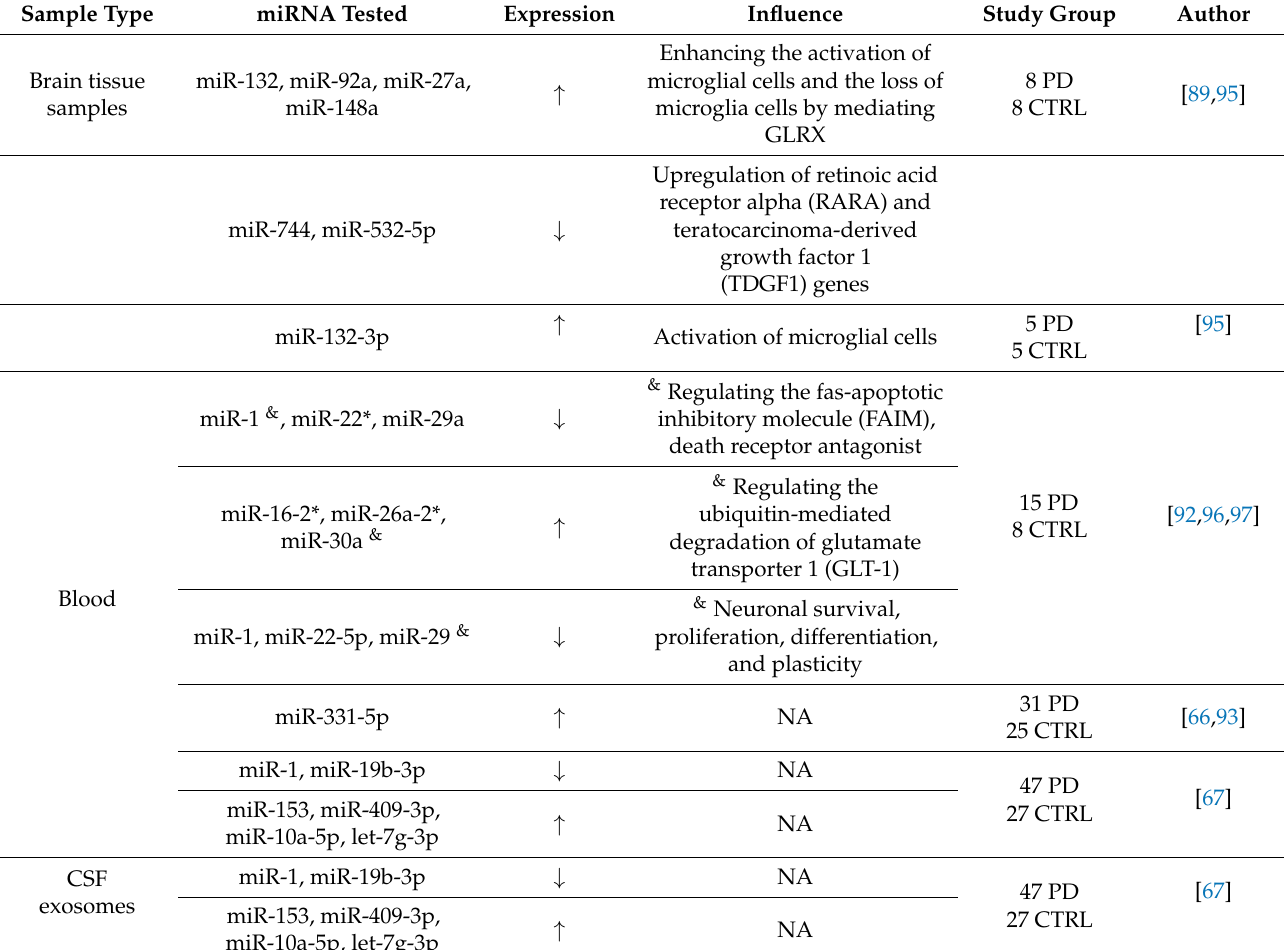
Table 2. Molecular biomarkers of